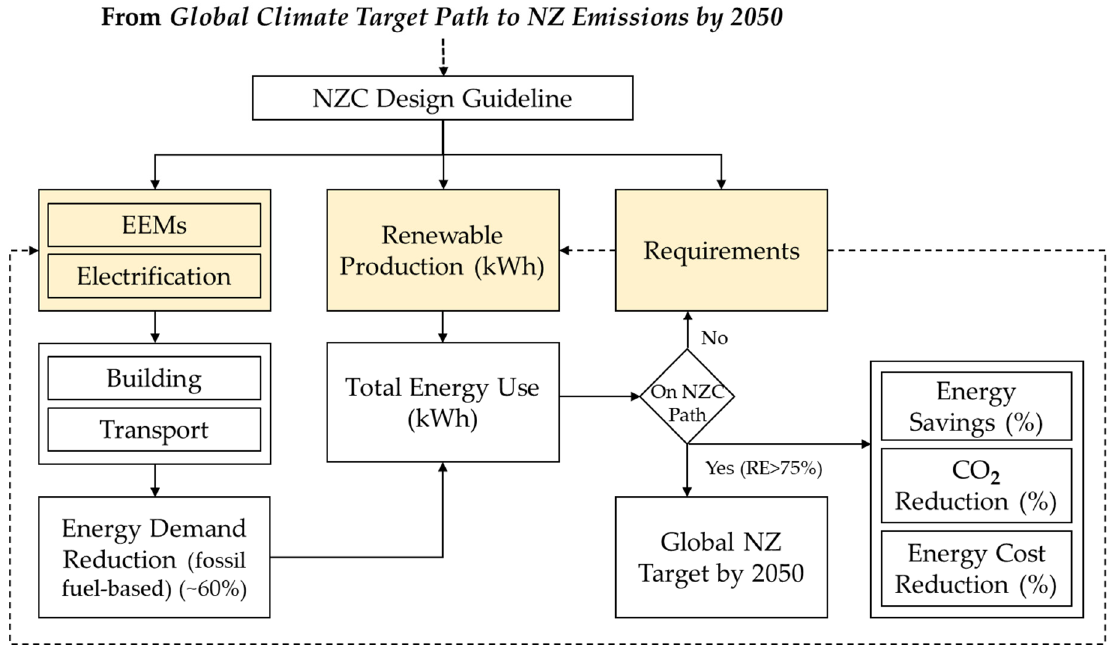
Figure 5. NZC Flowchart , energy balance in a community through EEMs, electrification, and renewables. According to the flowchart, a community could be on the NZ path by minimizing its